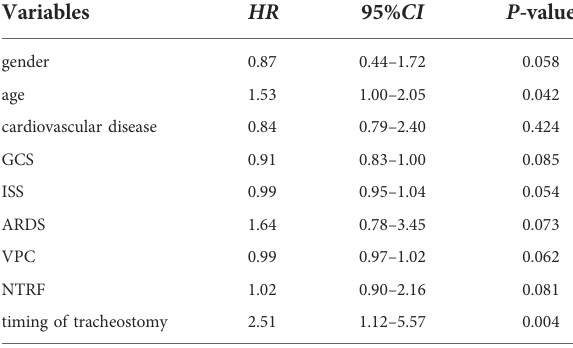
TABLE 3 COX survival analysis based 28-day mortality.